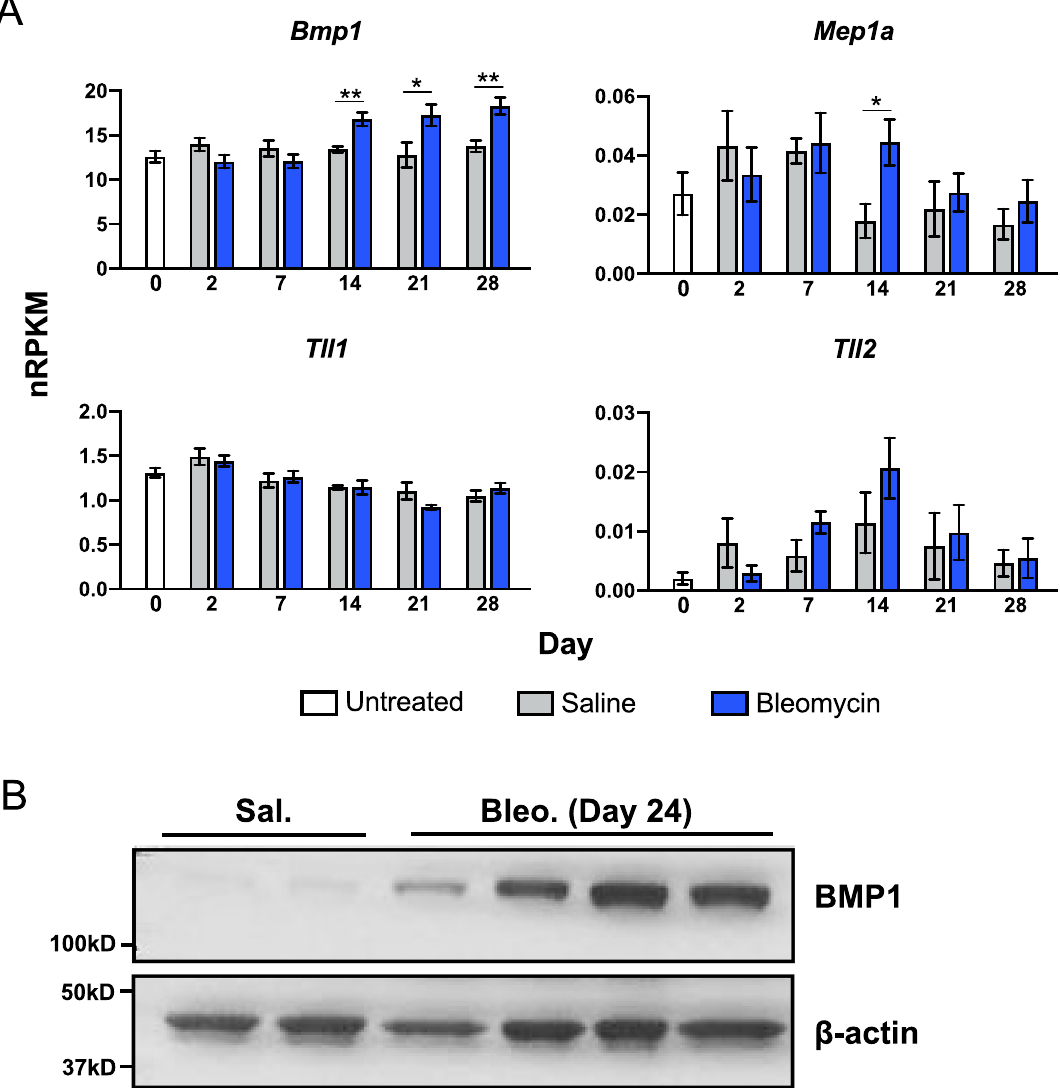
challenge compare to saline group, each lane represents single biological sample. β-actin is a loading